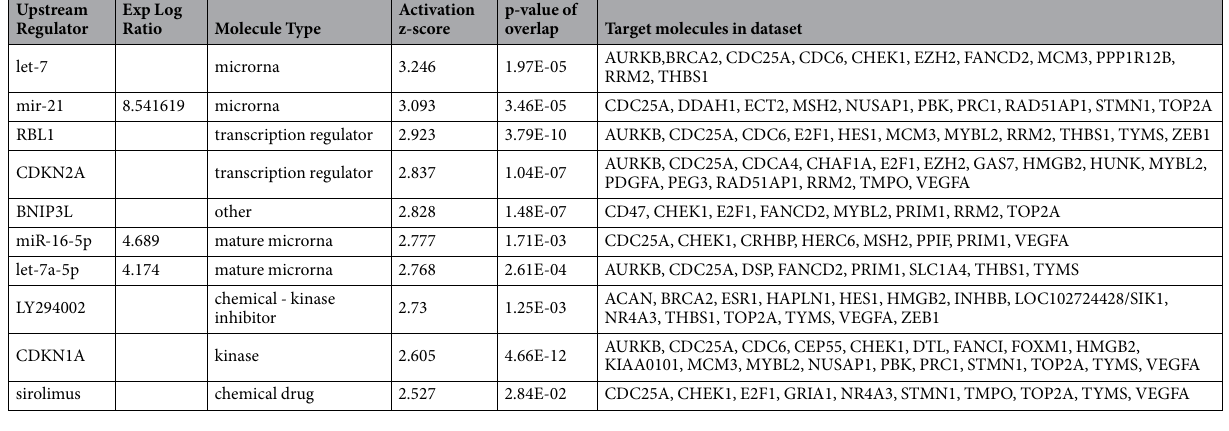
Table 4. Top 10 activated upstream regulators of negatively correlated miRNAs and targets identified by ingenuity IPA analysis 19